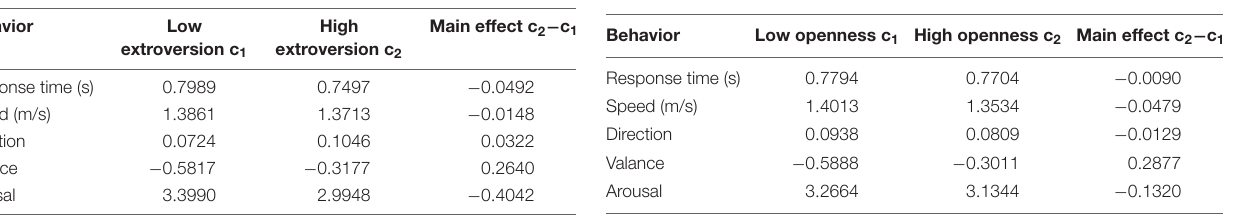
TABLE 4 | The main effect of extroversion on escape behavior. TABLE 5 | The main effect of openness on escape